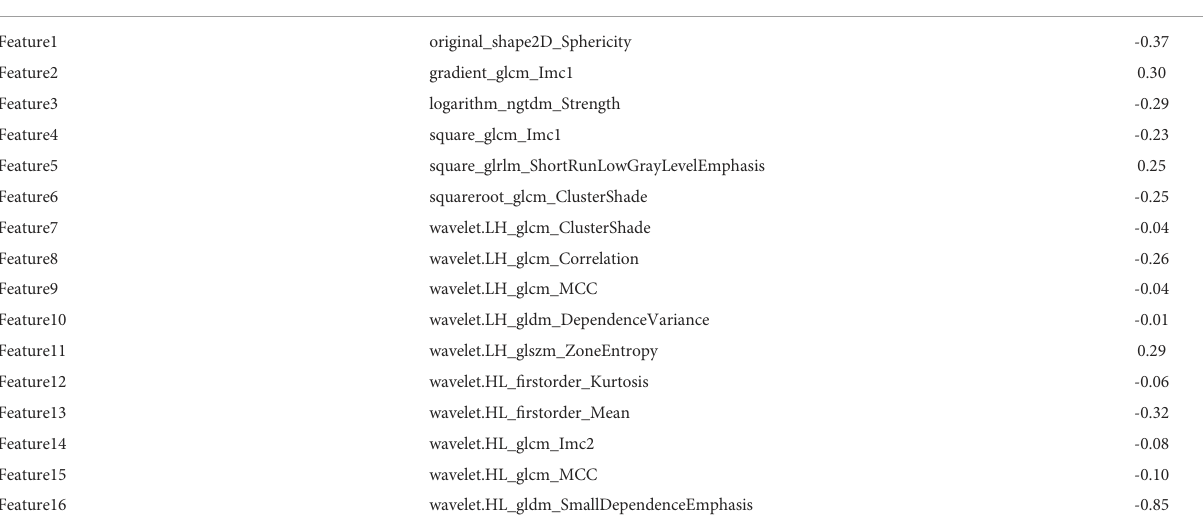
TABLE 3 Radiomics features and their coef fi cients that were included in the fi nal assessment of GIST